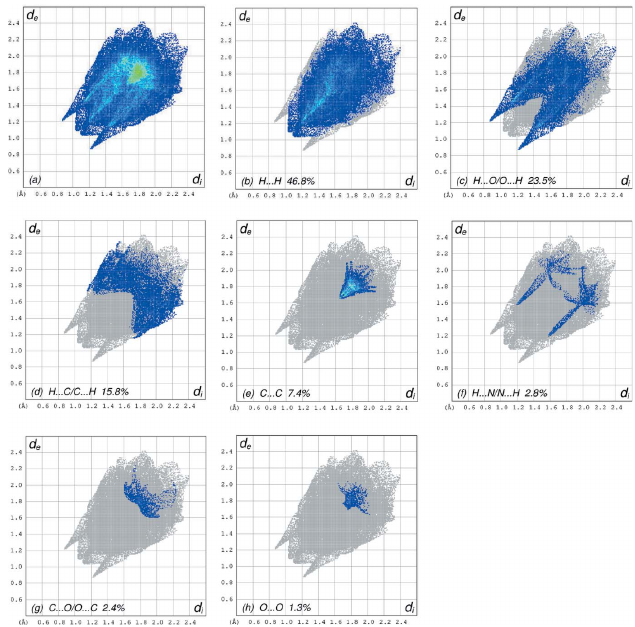
Figure 4 ( a ) View of the three-dimensional Hirshfeld surface of the title compound, plotted over d norm in the range of (cid:4) 0.3842 to 1.4934 a.u., ( b ) view of the three-dimensional Hirshfeld surface of the title compound plotted over electrostatic potential energy in the range (cid:4) 0.0500 to 0.0500 a.u. using the STO-3 G basis set at the Hartree–Fock level of theory and ( c ) Hirshfeld surface of the title compound plotted over shape-index.